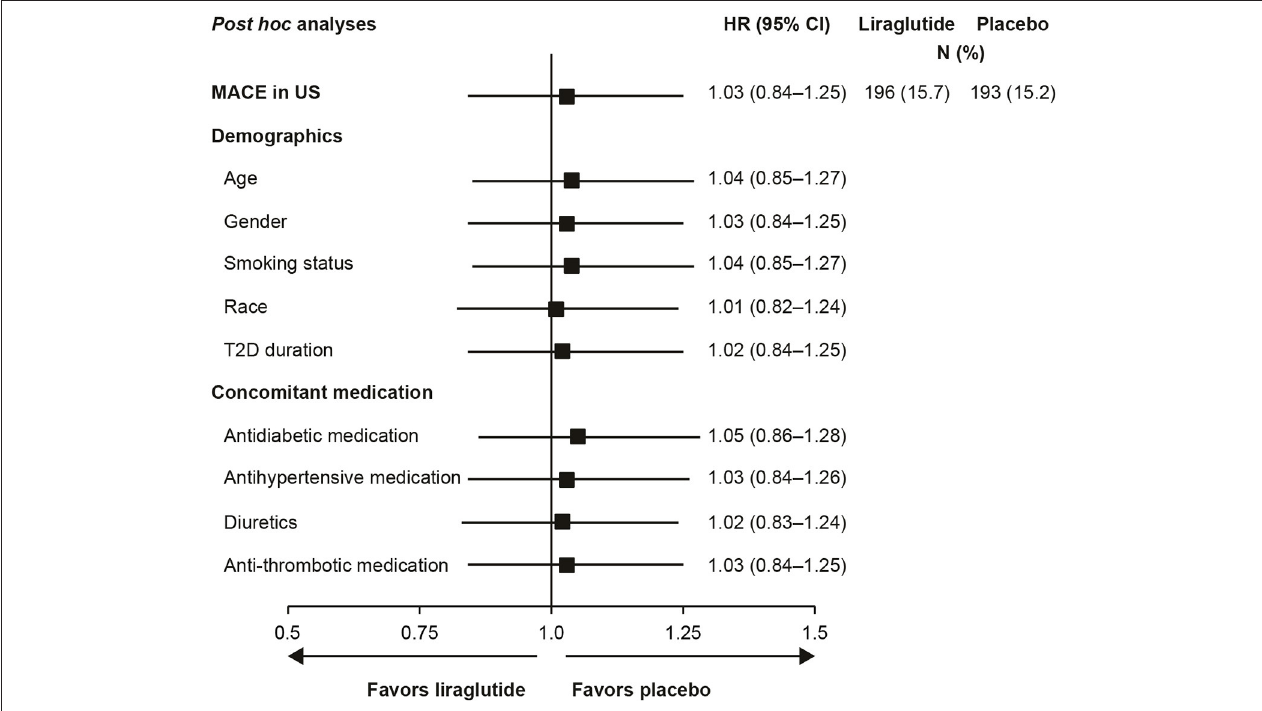
FIGURE 2 | Analysis of time to first MACE in US participants with adjustment for baseline demographics and concomitant medications (29). Full analysis set; HR with 95% CI. Each row presents results of a Cox proportional hazards model with treatment as factor and adjustment for each baseline demographic variable or concomitant medication. All HRs are for the comparison of liraglutide to placebo. CI, confidence interval; HR, hazard ratio; MACE, major adverse cardiovascular event; N, number of patients with an event; T2D, type 2 diabetes; US, United States.